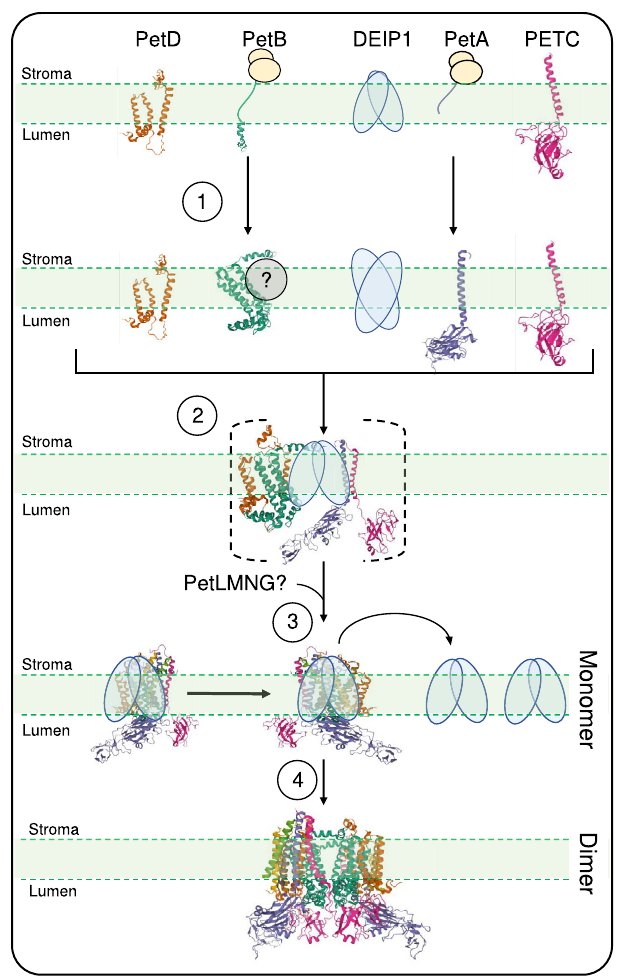
Fig. 9 Model of the role of DEIP1 in the assembly of the Cyt b 6 f complex. ① PetB and PetA are co-translationally inserted into the thylakoid membrane. Free DEIP1 is present as a homodimer. ② After its insertion into the membrane, PetD associates with PetB and DEIP1, and possibly other auxiliary factors. In parallel, PetA associates with PETC and DEIP1. The binding of DEIP1 to both heterodimers may bring the two subcomplexes in close proximity, thus facilitating their association. Transition of this unstable core complex to the stable monomeric Cyt b 6 f likely requires addition of the small subunits PetL, PetG, PetN, and PETM. ③ DEIP1 removal from the complex promotes the association of two monomers. ④ Formation of the stable dimeric Cyt b 6 f complex from two monomers completes the assembly process. See text for details. Images of the Cyt b 6 f complex and its subunits were obtained from rcsb.org 85 PDB ID 6RQF 25